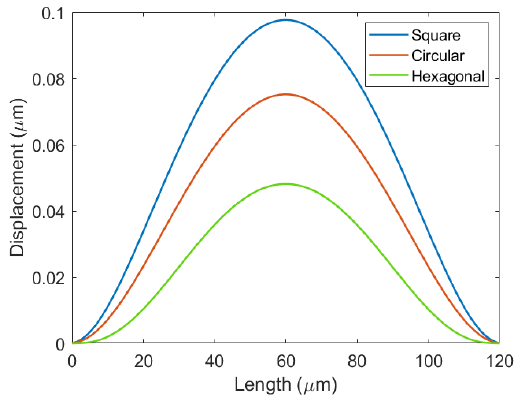
Figure 5. The membrane deflections of different shapes.